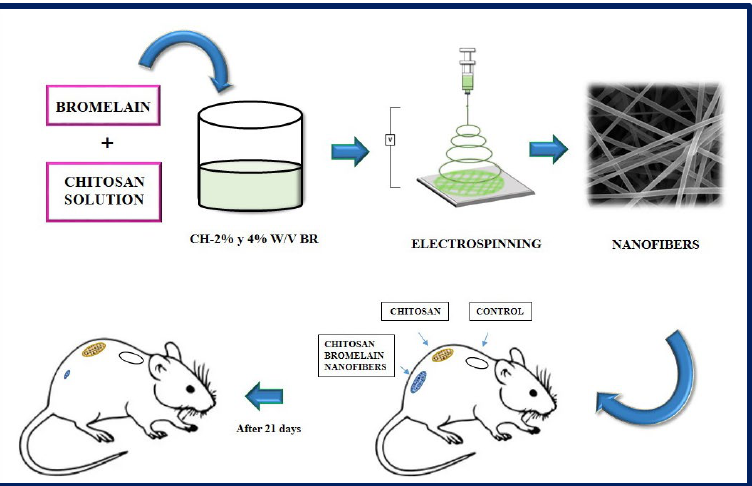
Figure 16. Chitosan nanofibers containing bromelain (2% and 4% w / v ) were prepared by electrospinning method. The burn wounds of the rats were treated with chitosan nanofibers, and chitosan-Bromelalin nanofibers. The results indicated that chitosan-2% w / v bromelain nanofiber was more efficient to heal burn skin compared to chitosan nanofiber alone in the animal model tested. Bibliography consulted [176].